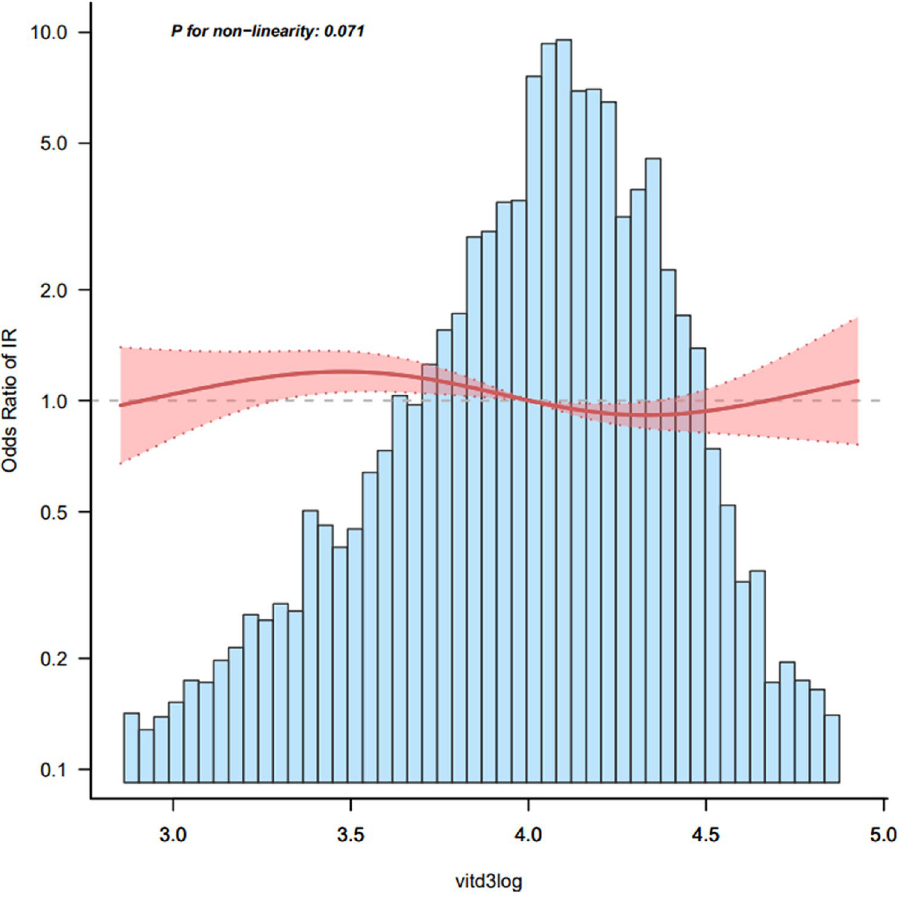
Figure 2. Association between Vitamin D3 and insulin